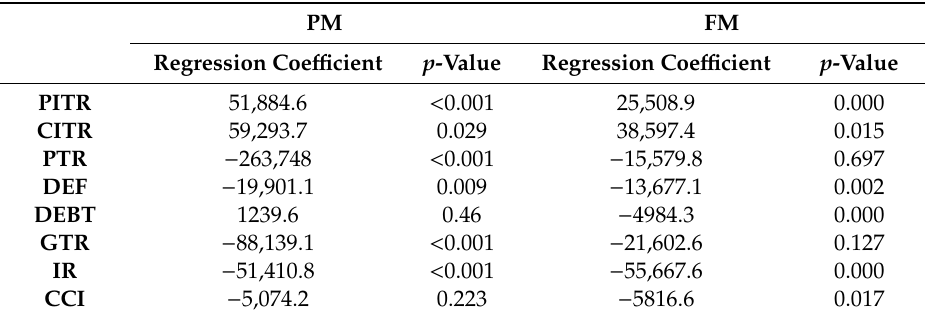
Table 4. Estimated models for the fourth group of